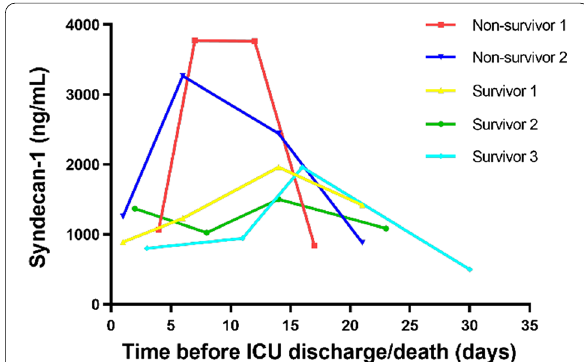
Fig. 4 Dynamics of the levels of syndecan-1 in five patients with